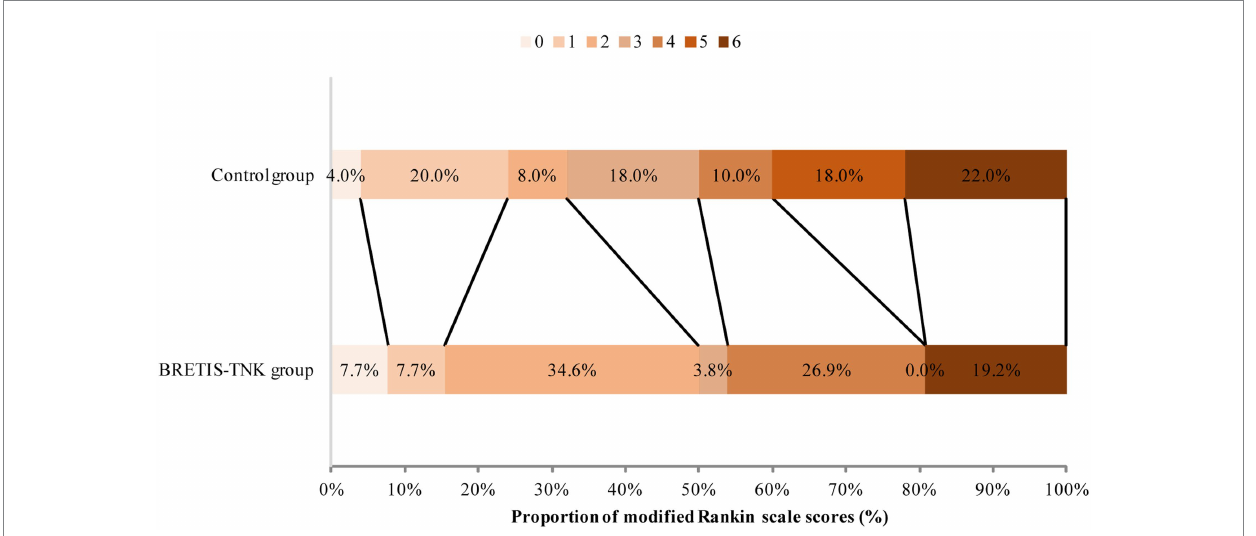
FIGURE 3 Distribution of functional scores at 90 days. Scores range from 0 to 6 (0 indicating no symptoms; 1, symptoms without clinically significant disability; 2, slight disability; 3, moderate disability; 4, moderately severe disability; 5, severe disability; 6, death). There was a trend toward higher proportion of functional independence at 90 days in the BRETIS-TNK comparing with the control group (50.0% vs. 32.0%, adjusted odds ratio, 2.32; 95% CI, 0.83– 6.51; p = 0.11) although not statistically